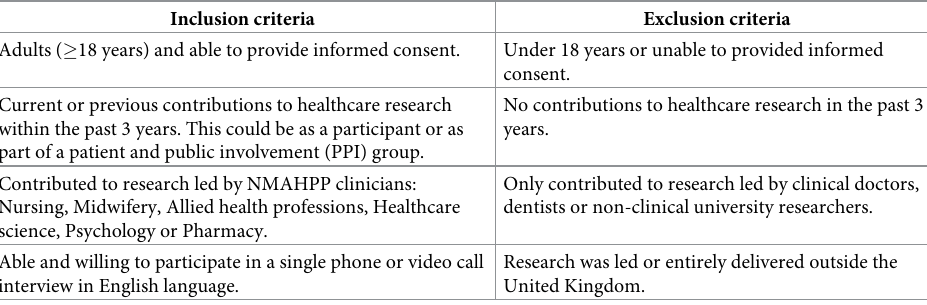
Table 1. Study eligibility